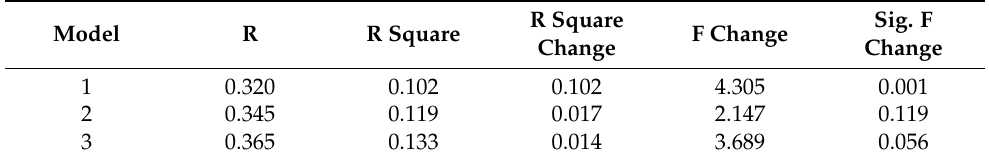
Table 4. Summary of the hierarchical multiple regression ( N = 234).